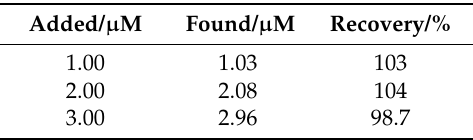
Table 2. Determination of NO 2 − in tap water samples.